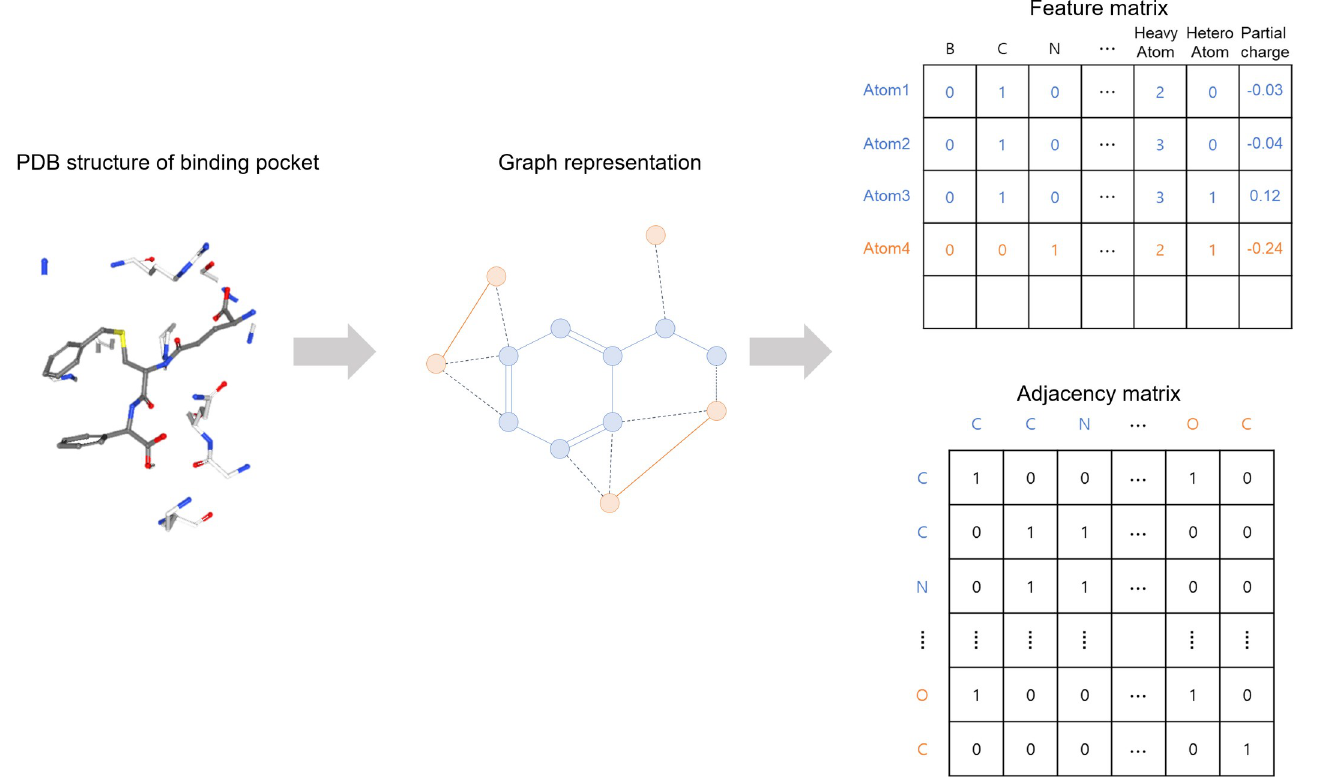
Fig 1. Graph representation of protein-ligand binding structure. The 3D structure of the binding pocket is represented as a graph. The features of the atoms and the features of the atomic interactions are embedded in the feature matrix and adjacency matrix, respectively.